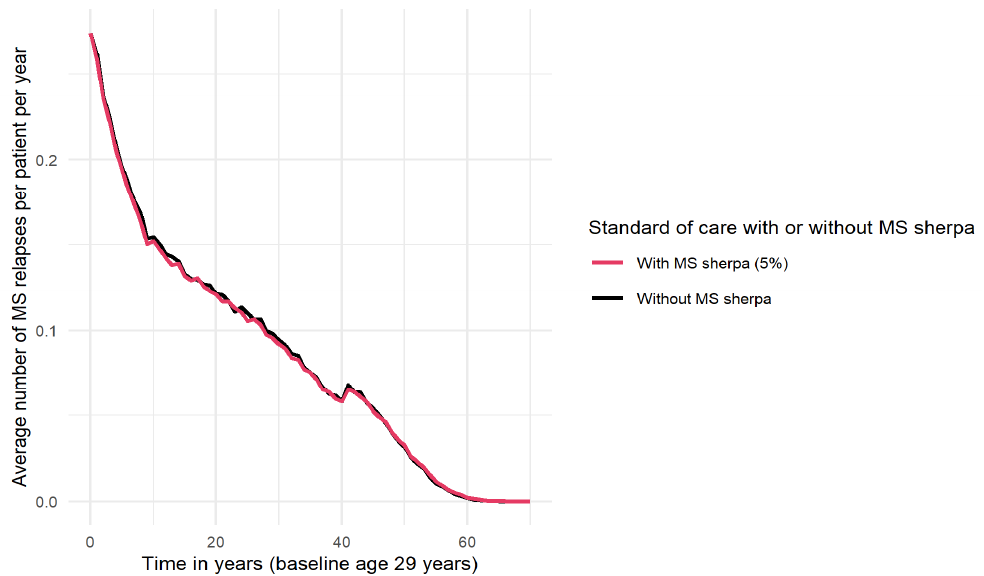
Figure 4. Average number of MS relapses per patient per year over time, with and without use of MS sherpa. The hiccup at t = 41 can be explained by the rule in the MS model (see Figure 2) that pwMS will discontinue DMTs at age 70 in the absence of disease activity ≥ 10 years and the risk of relapses is not reduced by the DMT anymore.